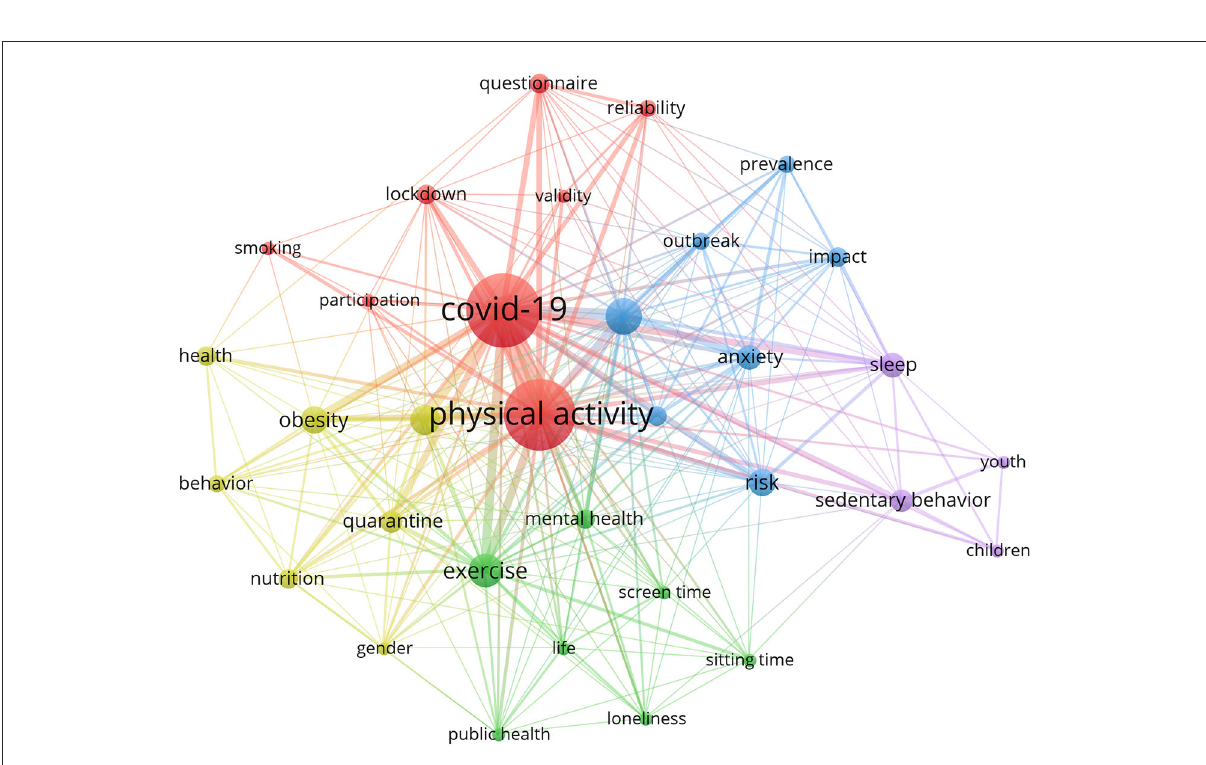
FIGURE5 Keyword co-occurrence